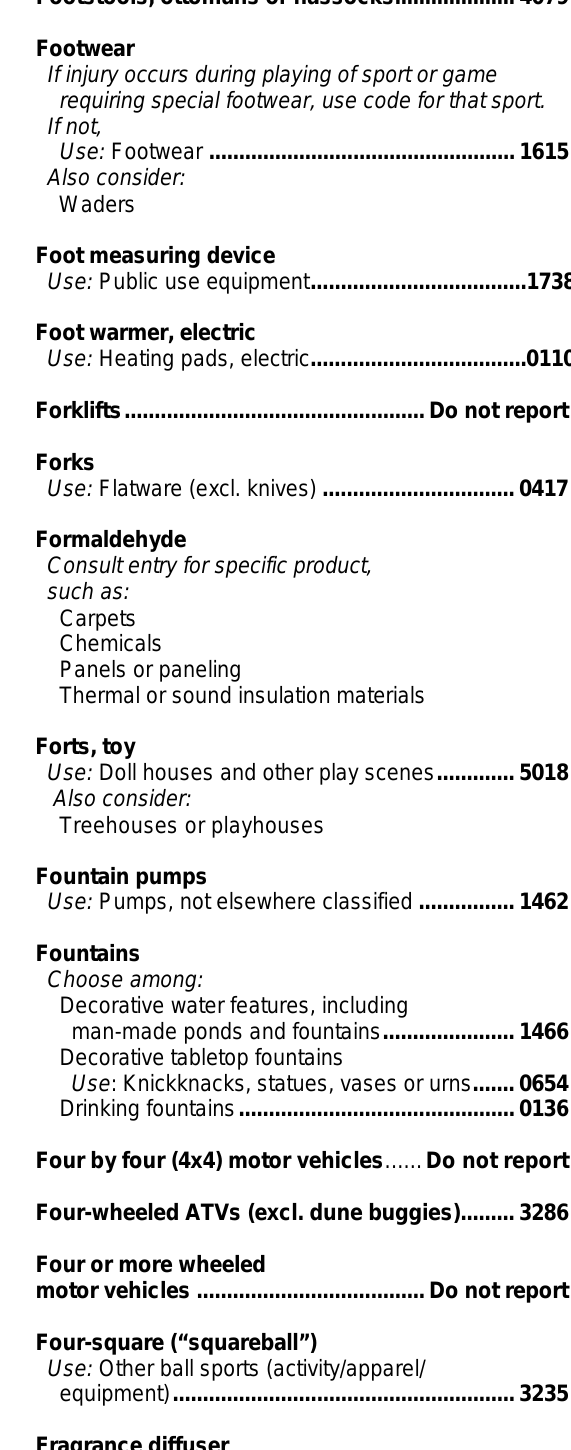
Footbag or kickbag ball Use: Sports and recreational activity,